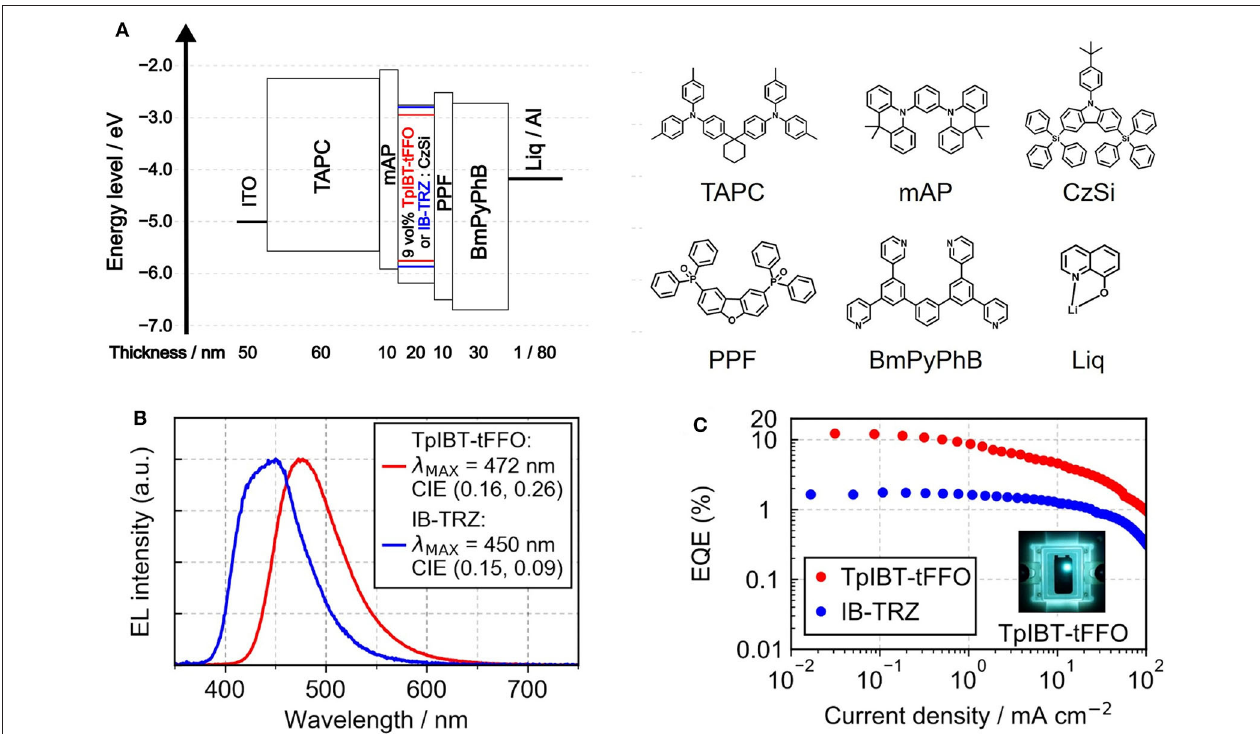
FIGURE 7 | (A) Device structures of the TpIBT-tFFO- and IB-TRZ-based OLEDs and the utilized materials. The HOMO/LUMO energy levels of TpIBT-tFFO and IB-TRZ are depicted in red and blue lines, respectively. (B) EL spectra of TpIBT-tFFO- and IB-TRZ-based OLEDs. (C) EQEs of TpIBT-tFFO- and IB-TRZ-based OLEDs as a function of current density.